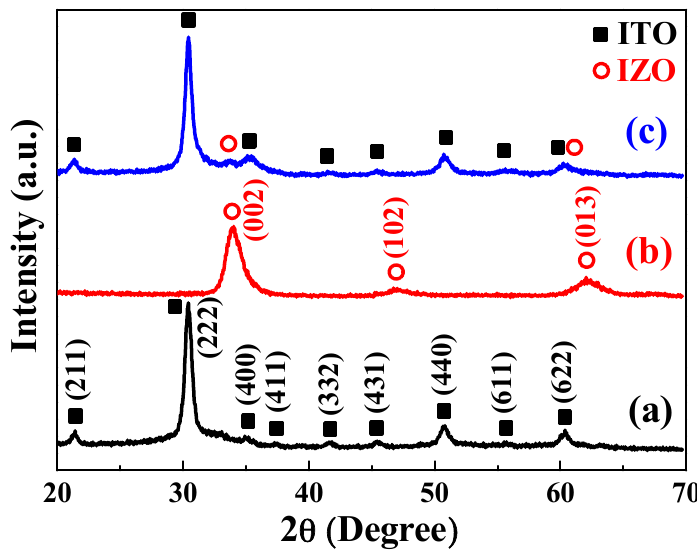
Figure 4. X-ray diffraction (XRD) analyses of thin films: ( a ) ITO; ( b ) IZO; and ( c ) ITO/IZO. The SEM images in Figure 5 show cross sections of the SiNWs formed after 10 min of etching. The large area of vertically aligned SiNW arrays with uniform length was successfully fabricated through metal-assisted chemical etching (MACE) of Si wafers. Figure 5a indicates that the length of the SiNWs is about 1.7 μ m, and the average diameter is about 120 nm (full width at half length of SiNW). In addition, the SiNWs have smooth surfaces with almost no pores as shown in Figure 5b. The result is identical to that produced by Xiaopeng Qi et al. [32].